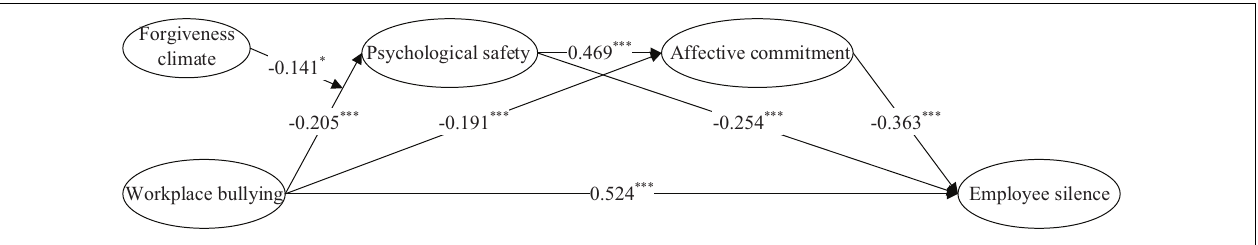
FIGURE 2 | Mediating-moderating model estimation. In order to keep the graphics concise, this paper does not draw the path coefficients of control variables to core variables into the graph; The results in the figure are obtained from two analyses: mediating model test results and mediating effects of workplace bullying and forgiveness climate on the first stage;+ was significantly correlated at the level of 0.1 (bilateral), and *** was significantly correlated at the level of 0.001